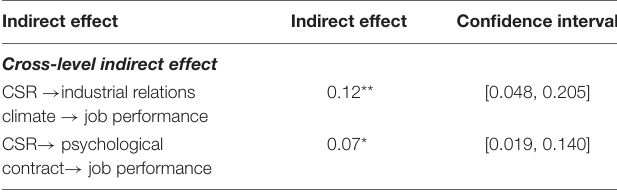
TABLE 4 | Results of cross-level indirect